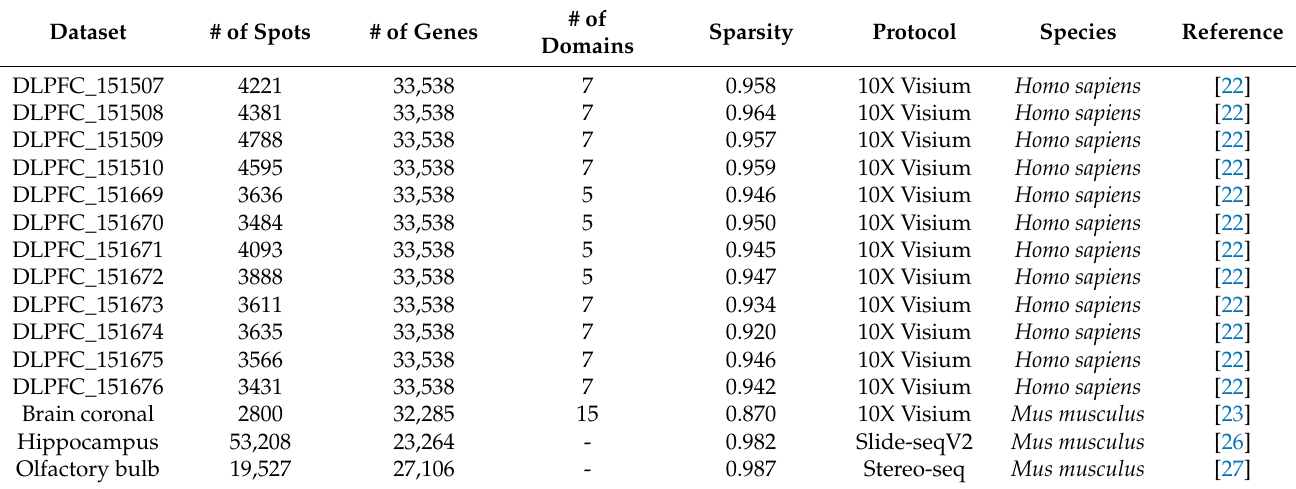
Table 1. Summary of the fifteen benchmarking